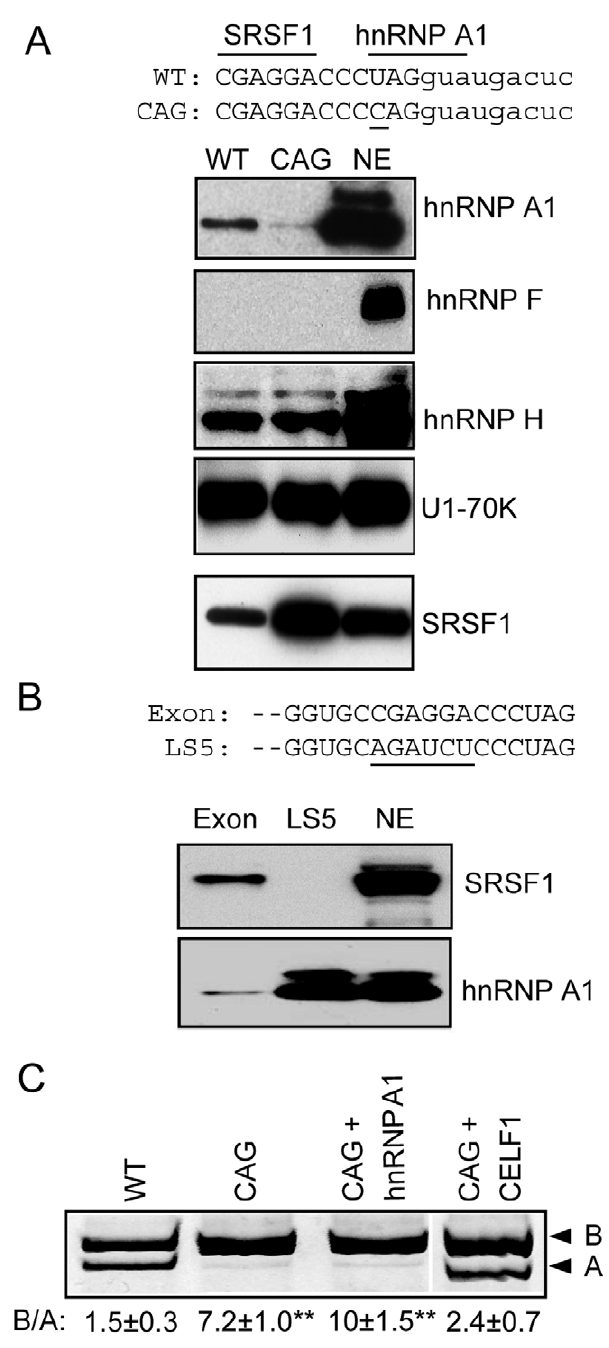
Figure 5. hnRNP A1 but not hnRNP F binds at the junction of exon 11 and intron 11 to repress exon inclusion. Panel A: The nucleotide sequence of the RNA templates of the wild type exon 11/ intron 11 junction and the -3U R C mutation (underlined). Binding sites for SRSF1 and hnRNP A1 are indicated by bars above. Representative blots show the results of in vitro RNA pull-down assays followed by immunoblotting for hnRNP A1, F, H, and U1-70K and SRSF1. Panel B: The nucleotide sequence of the RNA templates of the wild type exon 11 and the LS5 mutation (underlined). Representative blots show the results of in vitro RNA pull-down assays followed by immunoblotting for hnRNP A1 and SRSF1. Panel C: Transient transfection of the wild type minigene hIR and the -3U R C mutant in the absence and presence of the expression vector of hnRNP A1 or CELF1. A representative gel is shown. The ratio of isoform B over isoform A of n=3 experiments with 6 SD is shown. Asterisks indicate statistical significance vs. wild type (** p # 0.01).